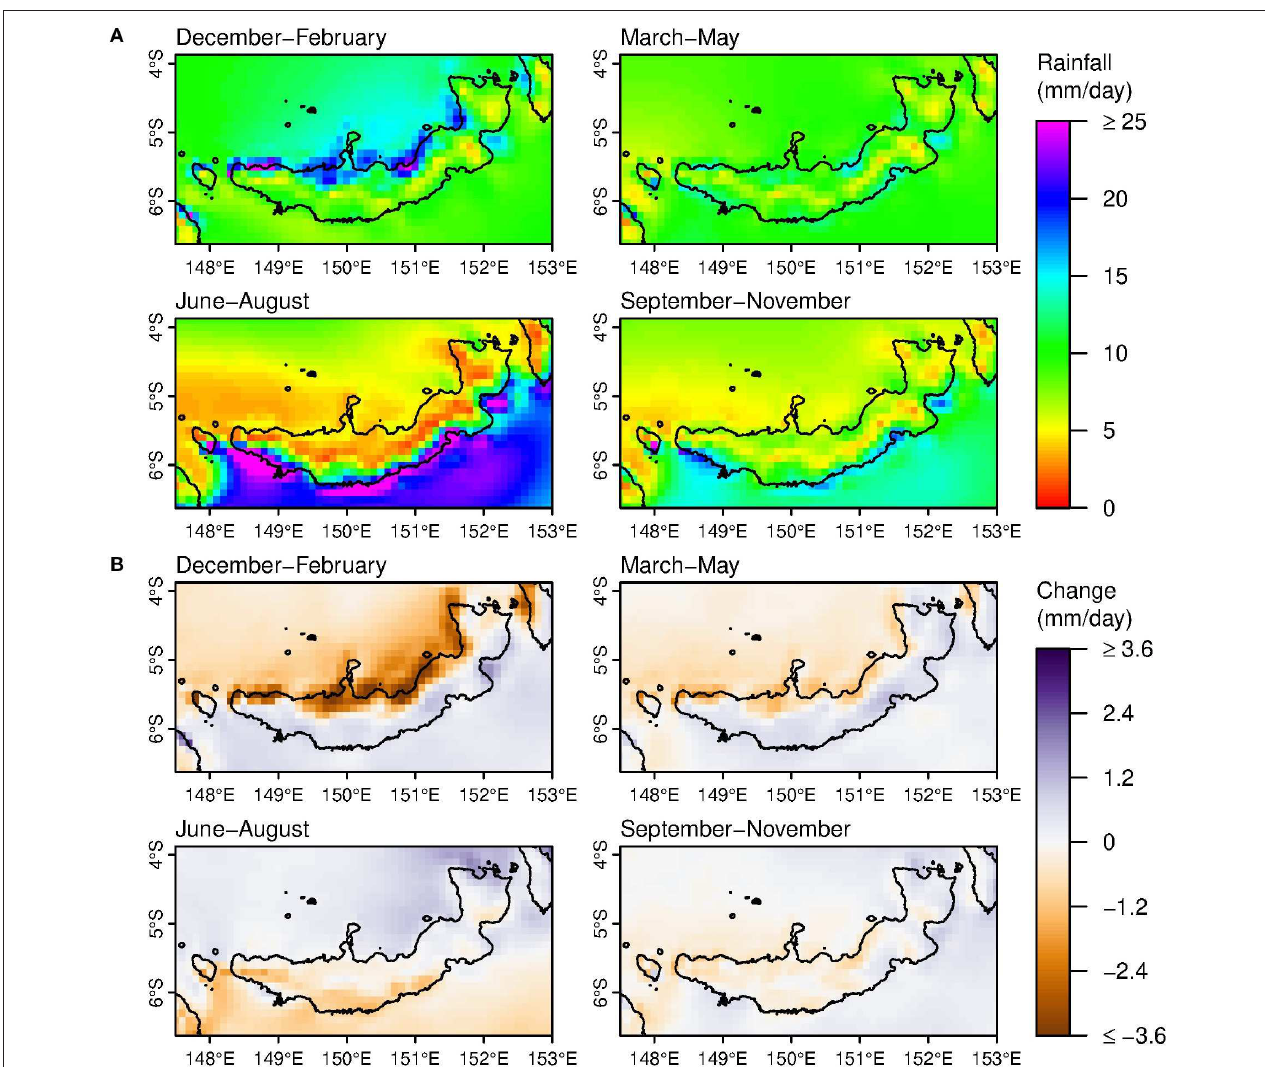
FIGURE 3 | Downscaled seasonal rainfall projection changes for New Britain in 2055 at 8km resolution, showing (A) projected rainfall and (B) changes relative to 1990. Simulations are for the global SRES A2 emissions scenario (see McGregor et al., 2016 for methodological details).